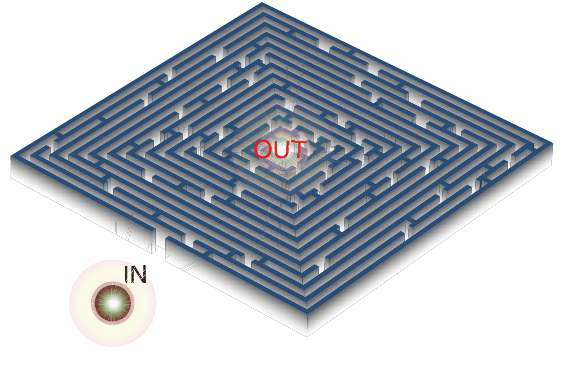
Figure 1 | Maze problem. Pictorial view of a maze with single input (IN) and output (OUT) ports. An ideal walker has to travel from IN to OUT in the shortest possible